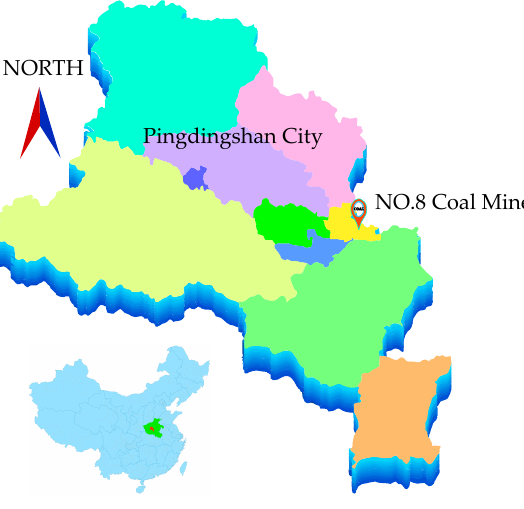
Figure 1. Geographic position of the coal mine.